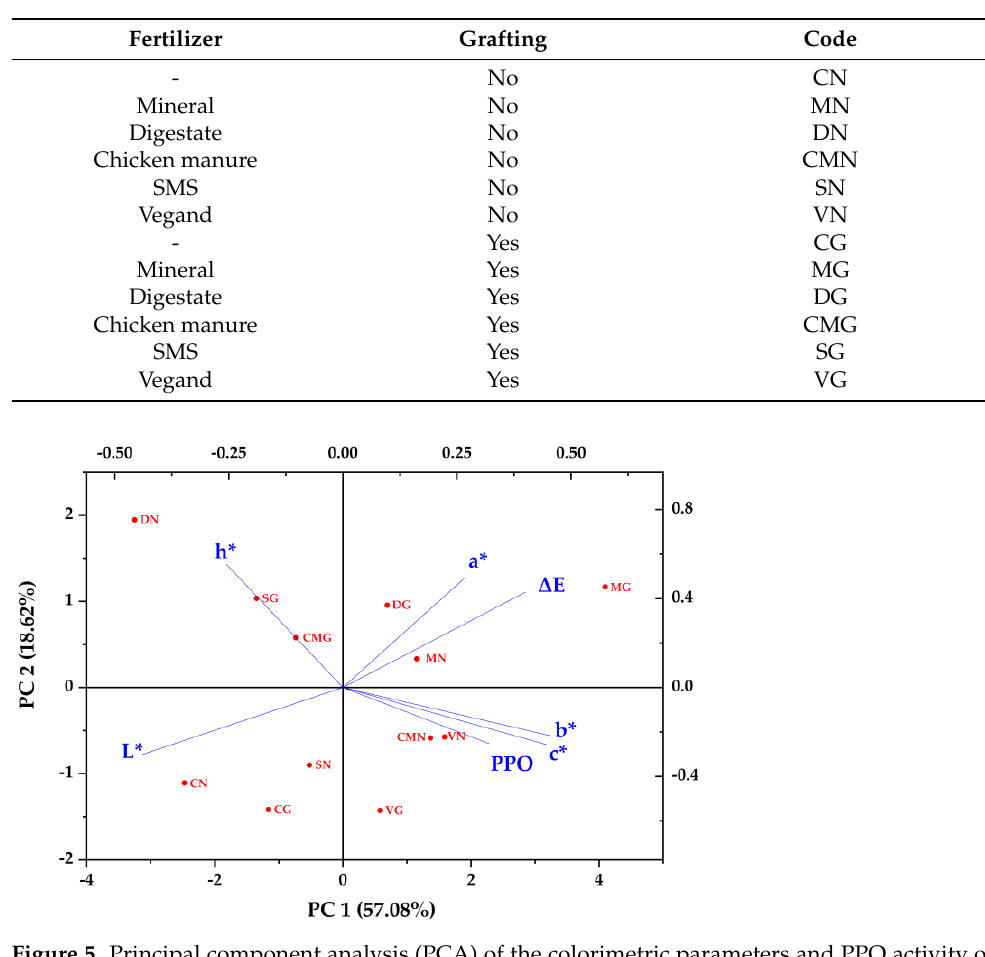
Figure 5. Principal component analysis (PCA) of the colorimetric parameters and PPO activity of eggplant fleshes. Sample Codes are defined in Table 3.